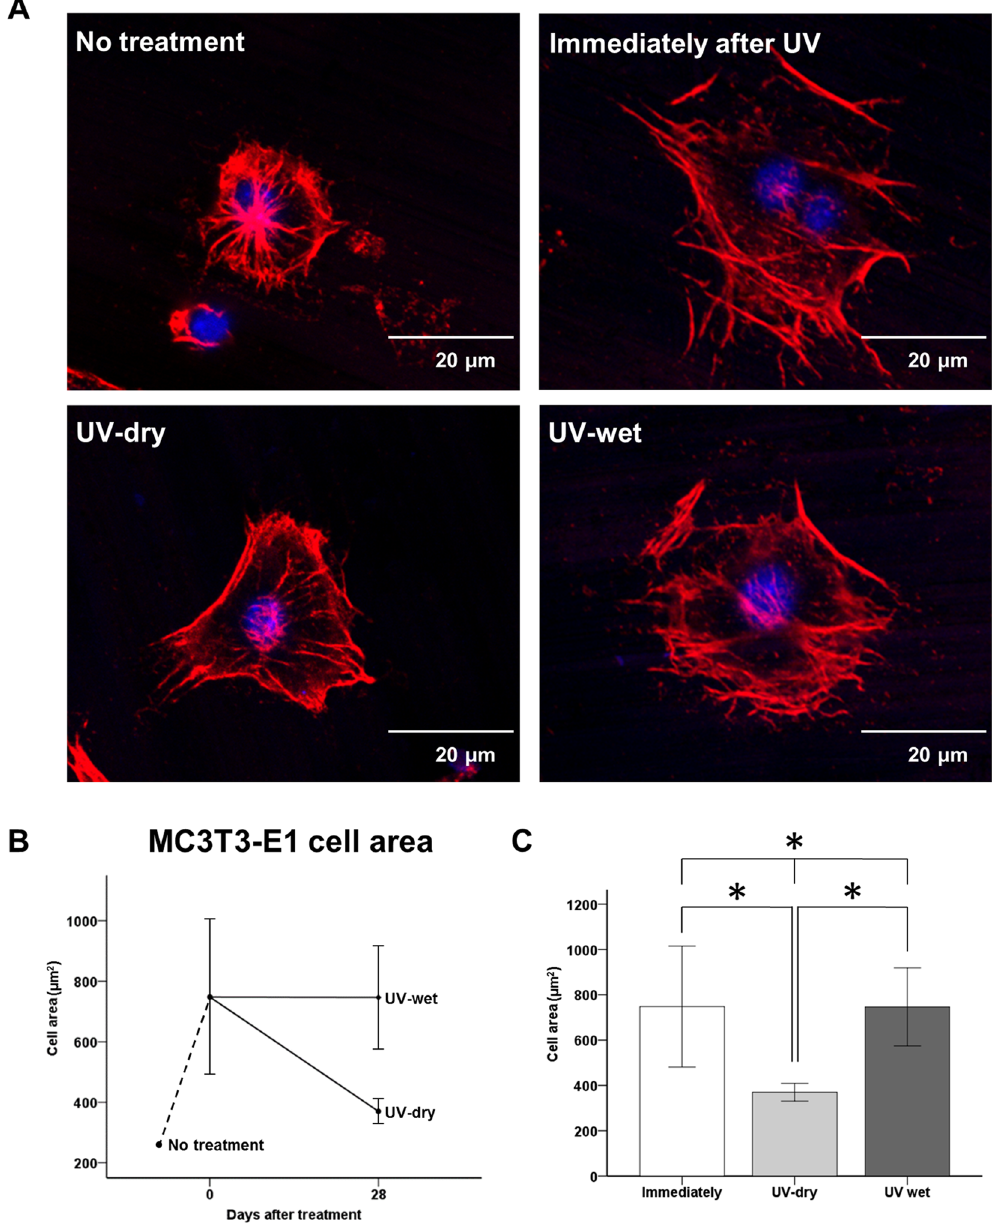
group. * P < 0.05 for comparisons between